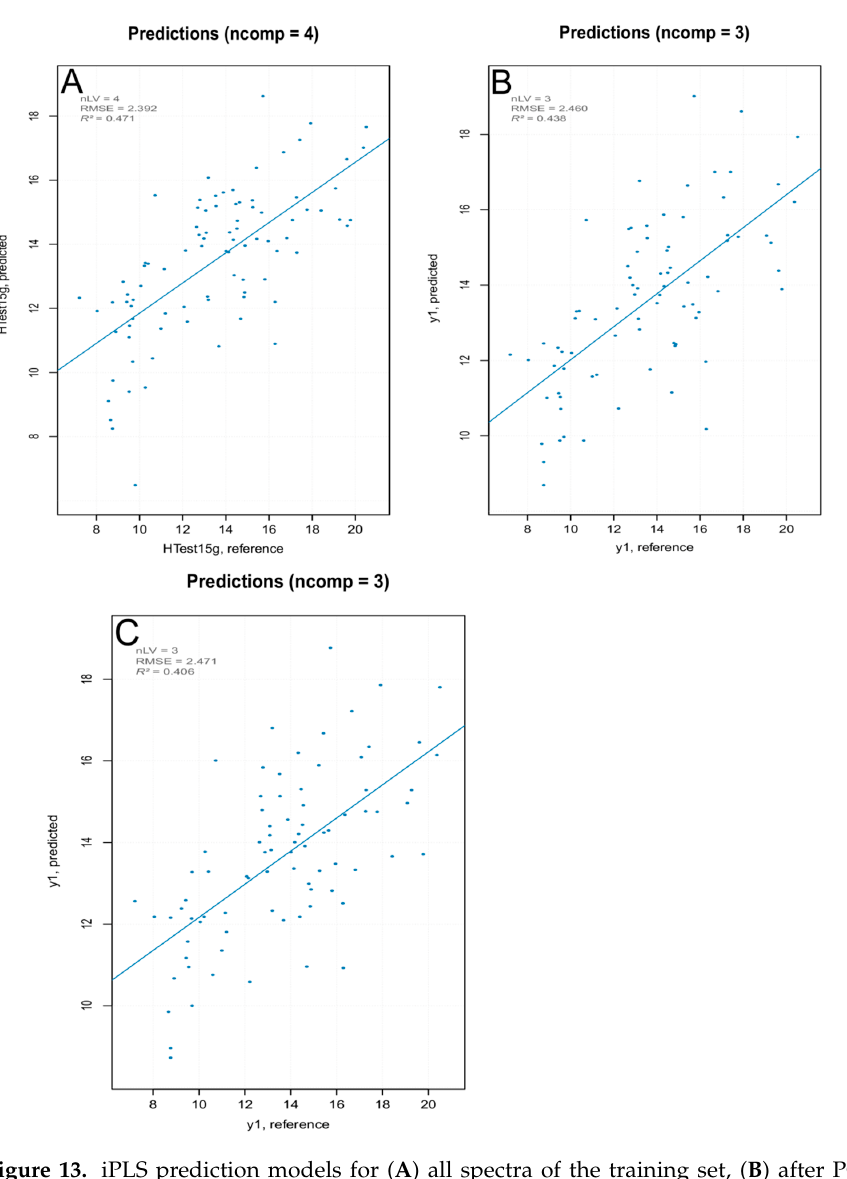
Figure 13. iPLS prediction models for ( A ) all spectra of the training set, ( B ) after PCA outliers removal, and ( C ) after extreme spectra removal.